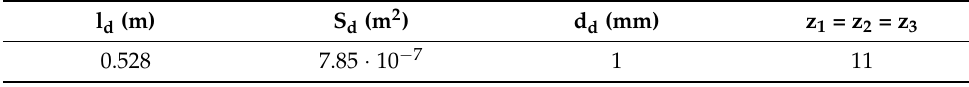
Table 1. Values of the geometrical parameters of the coupled inductor.